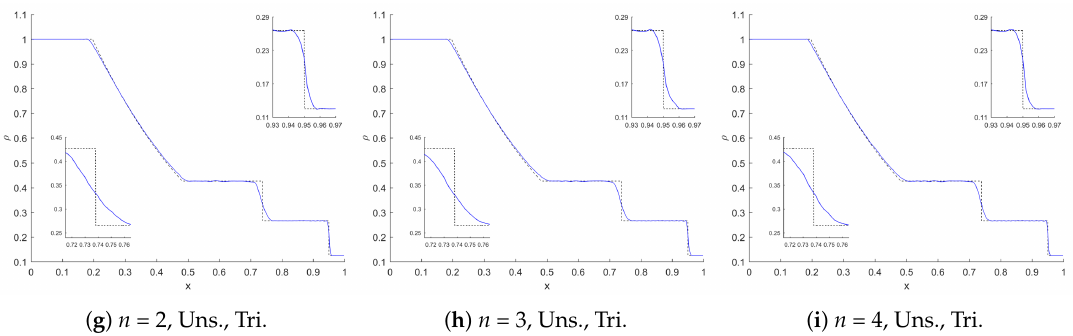
Figure 6. Two-dimensional shock tube problem with initial pressure ratio 10, various polynomial orders, and different types of grids. In each plot, the top-right inset figure is the result near the shock wave and the bottom-left inset figure is the result near the contact